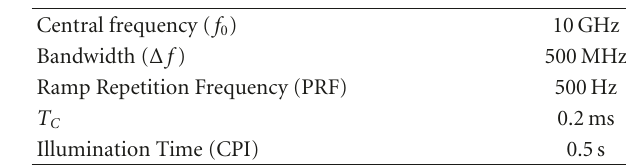
Table 1: LFMCW radar parameters for the simulated example in Figure